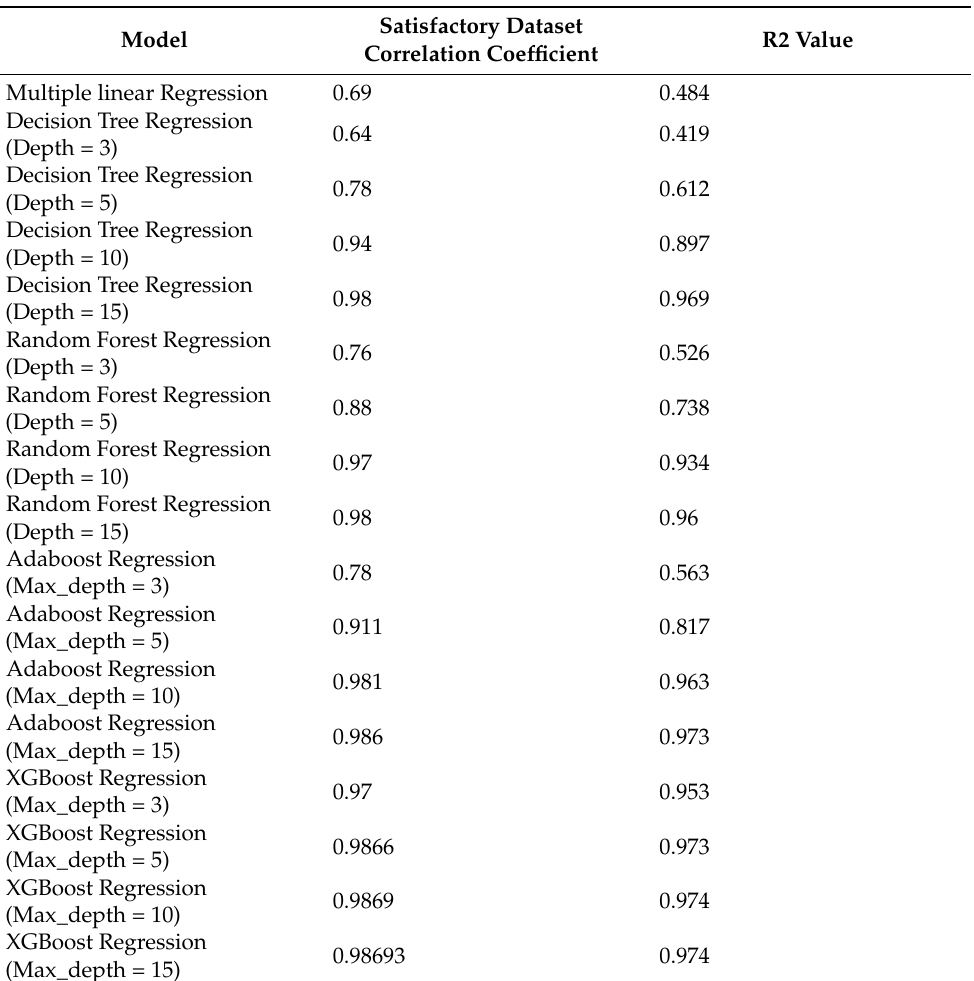
Table 2. Results Summary by Considering All